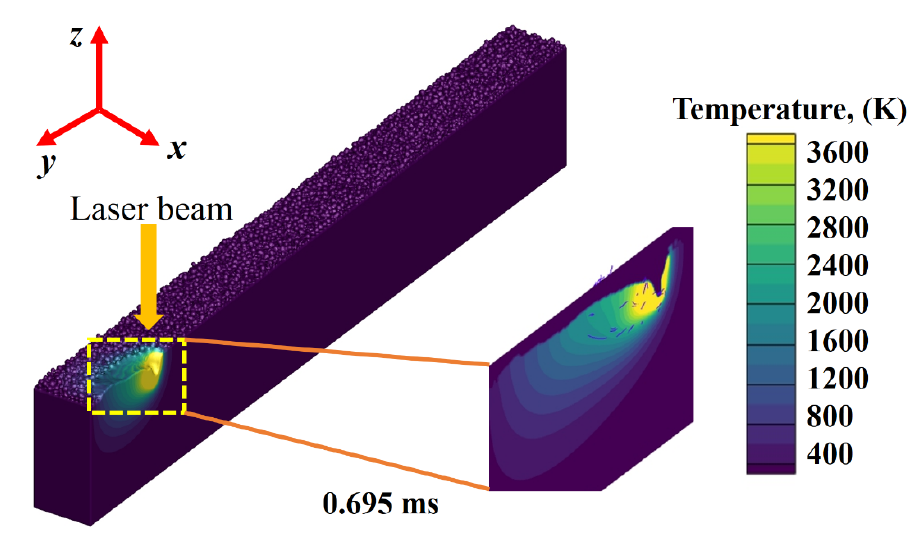
Figure 4. Detailed view of shallow depth melt mode with temperature field at 0.695 ms.